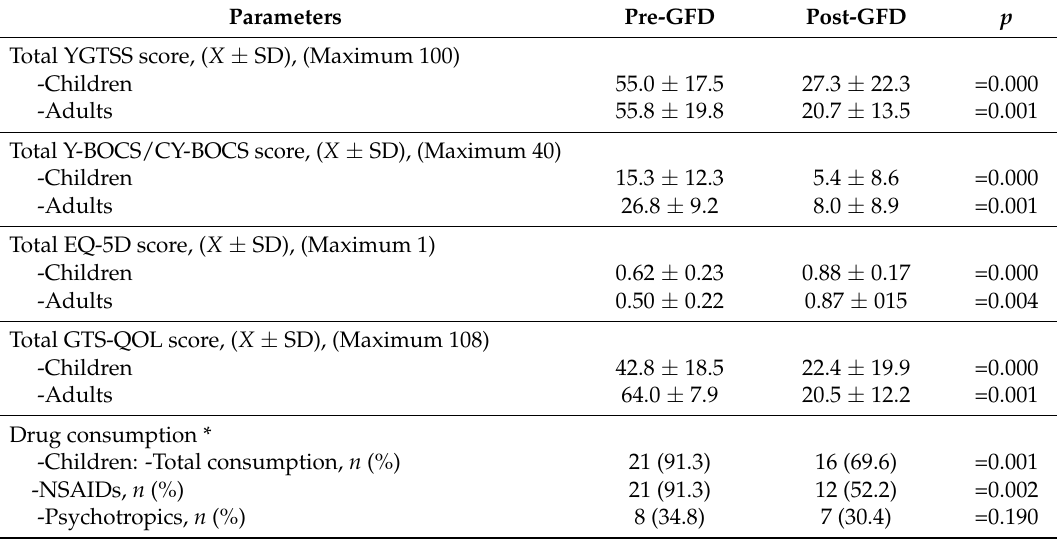
Table 3. Evolution of neurological symptoms and quality of life after 1 year of a